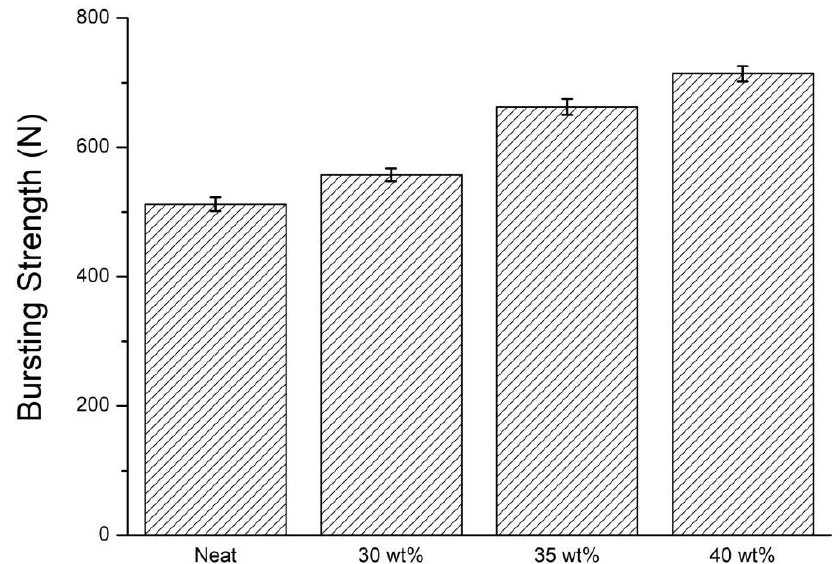
Figure 8. Bursting strength of STF composite nonwoven fabrics as related to the STF concentration. Table 3. Summary of bursting strength and dynamic impact data.